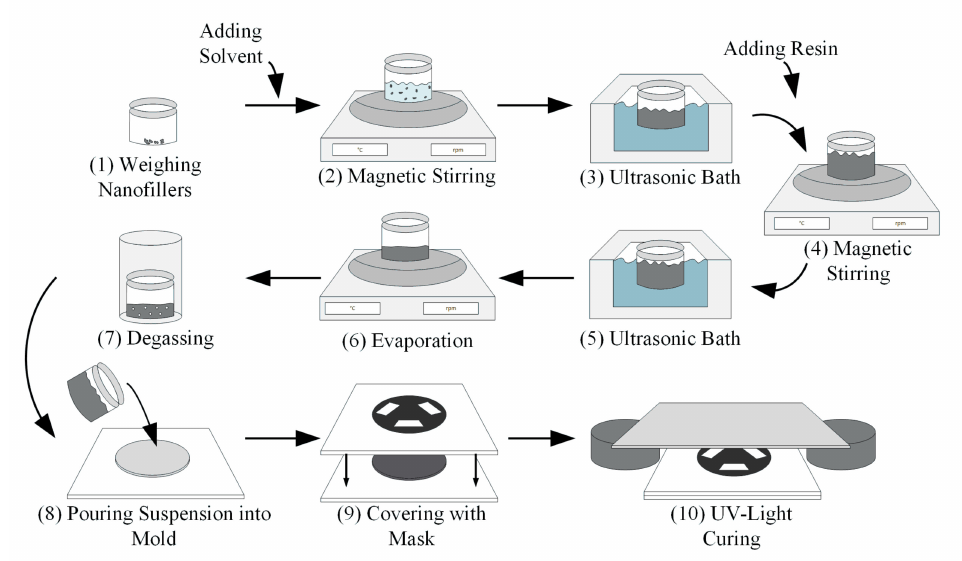
Figure 2. Schematic process diagram of suspension preparation and 0-3 nanocomposite